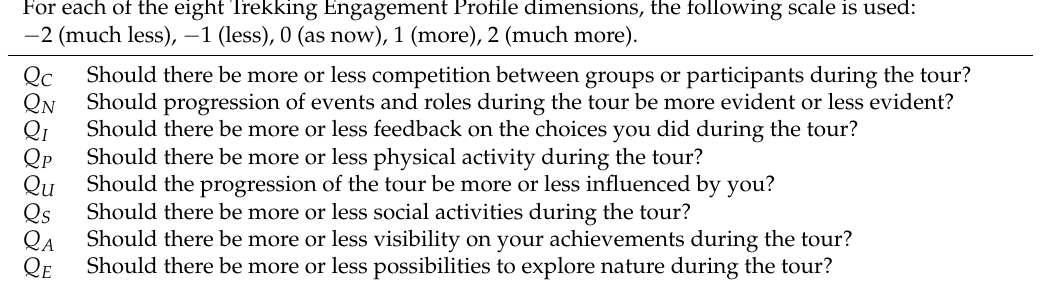
Table 2. Formulation of the questions and scales for the tourist’ opinion.